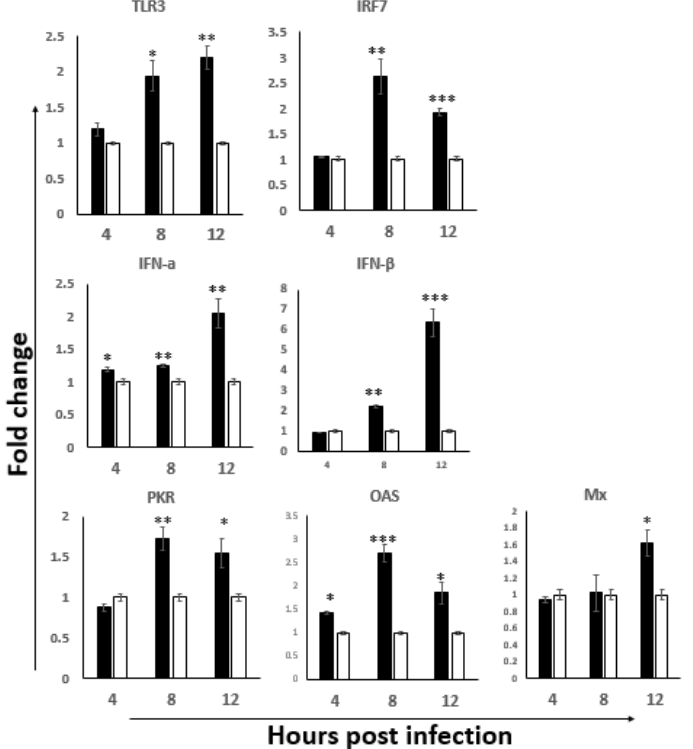
Figure 2. The gene expression level of TLR3 antiviral pathway in the ILP cells of NN1172 infected birds. The mRNA expression levels of TLR3, IRF7, IFN- α , IFN- β , PKR, OAS and Mx were detected at 4, 8 and 12 hpi. Results represent mean ± SEM, n = 5. (* p < 0.05; ** p < 0.01; *** p < 0.001) between the infected-group (black bar) and the uninfected-group (white bar).